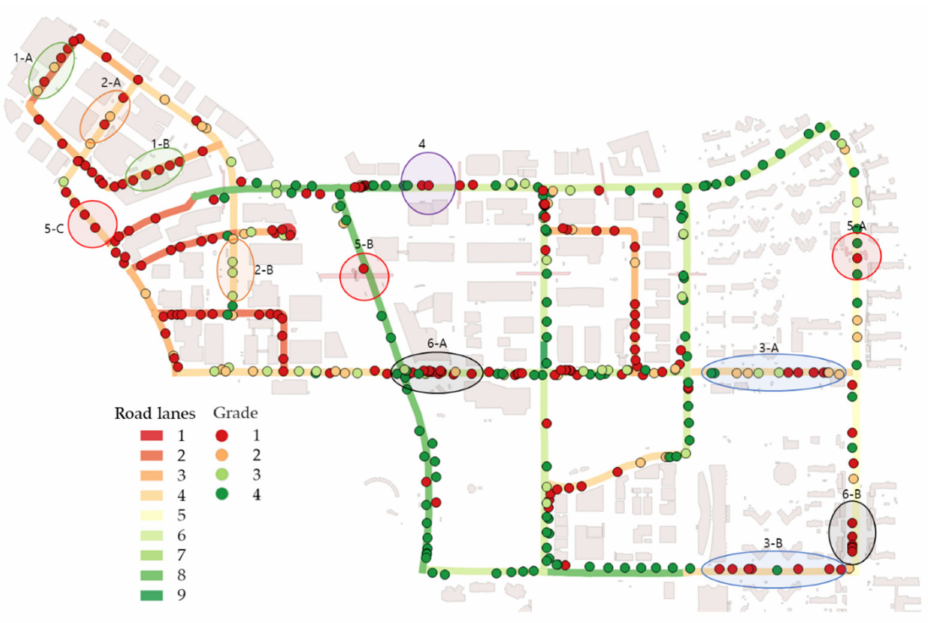
Figure 12. Locations of six zones identified in Pangyo.